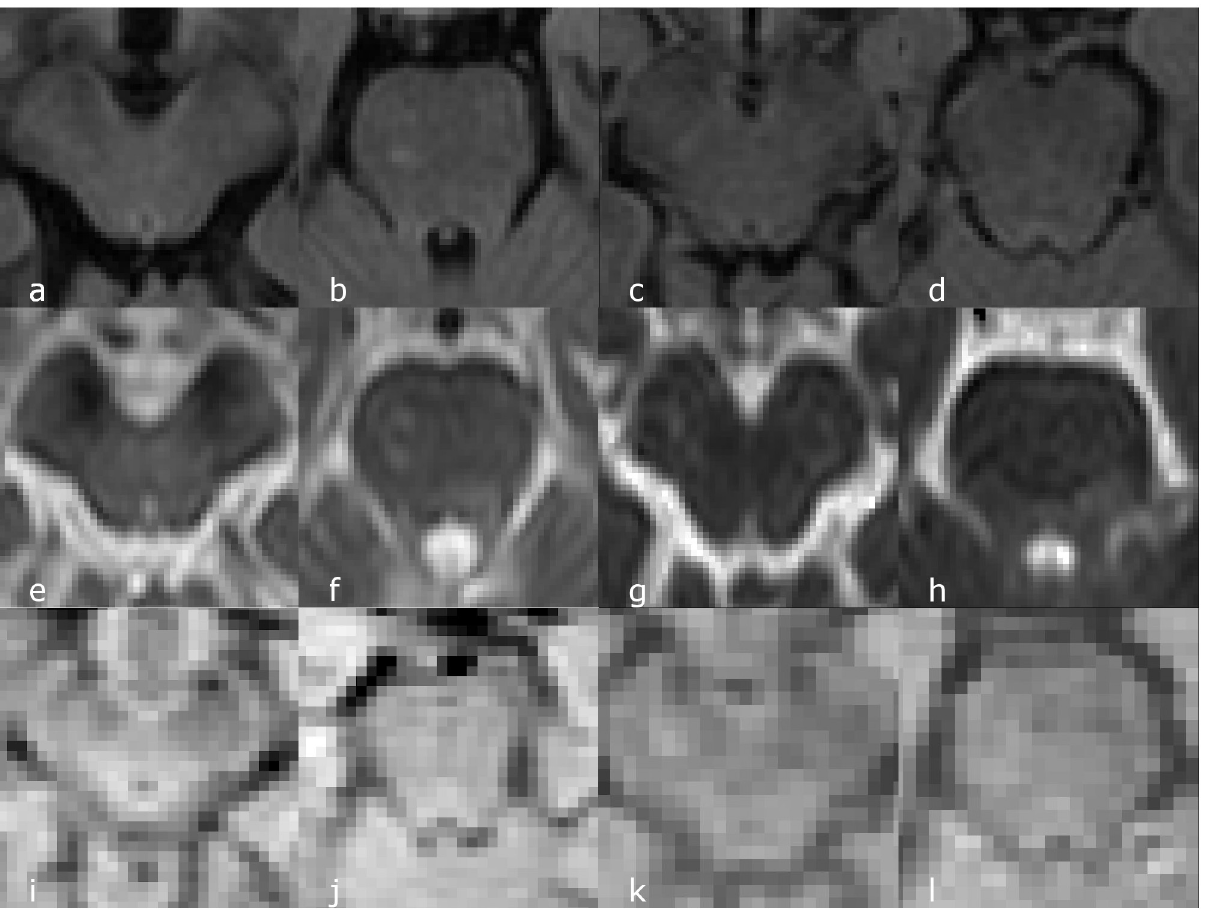
Fig 1. Example images. Example FLAIR images from a iNPH patient (a, b) and control (c, d) with corresponding ADC (e-h) and time averaged perfusion raw data (i-l) at the level of the mesencephalon and pons.